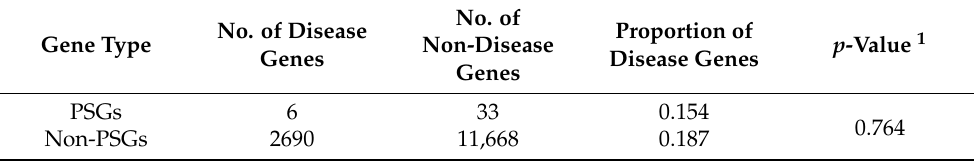
Table 6. Association test of human PSGs with human disease.